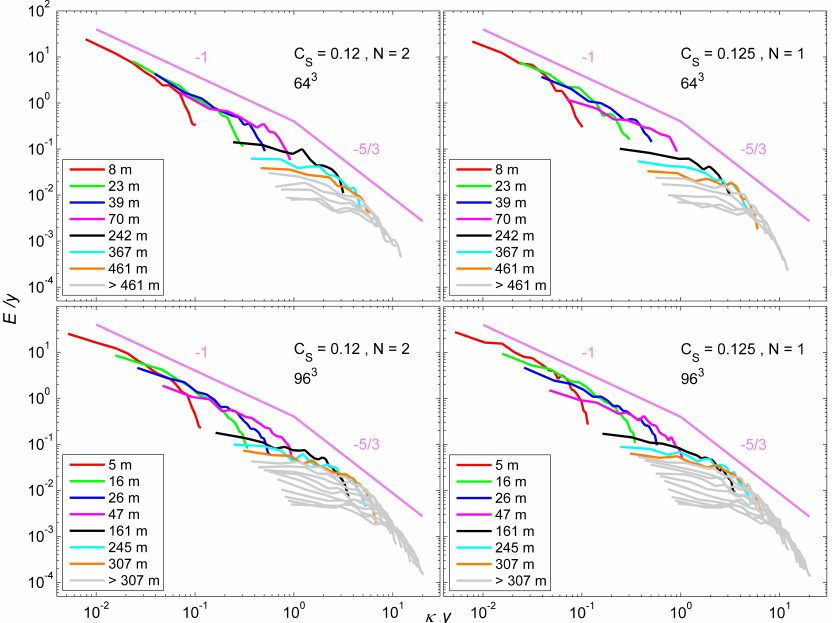
Figure 13. The energy spectra with height on 64 3 ( top ) and 96 3 ( bottom ), for C S = 0.12, n = 2 ( left ) and C S = 0.125, n = 1 ( right